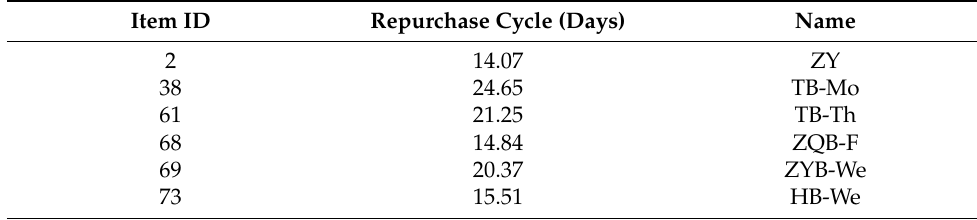
Table 2. Repurchase cycle of typical items included in I A | U A